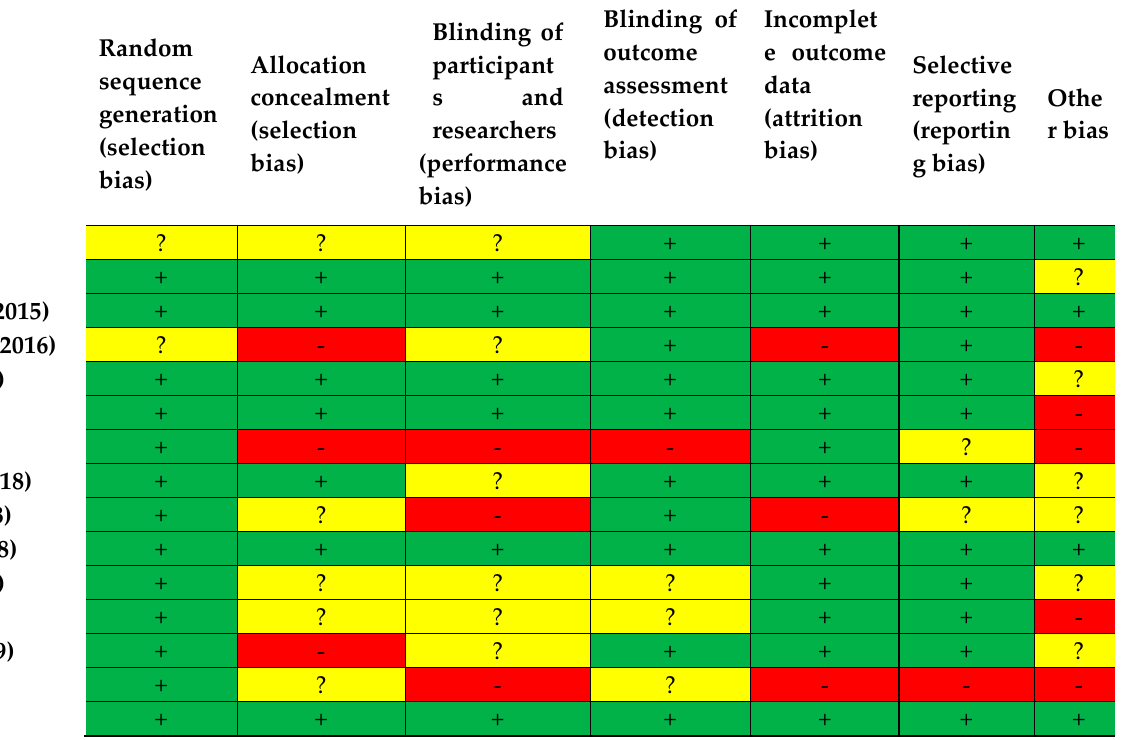
Figure 2. Risk of bias summary for each of the included RCT studies (n = 15). The green color with a plus sign indicates low risk of bias; the yellow color with a question mark indicates an unclear risk of bias, and the red color with a minus sign indicates high risk of bias.